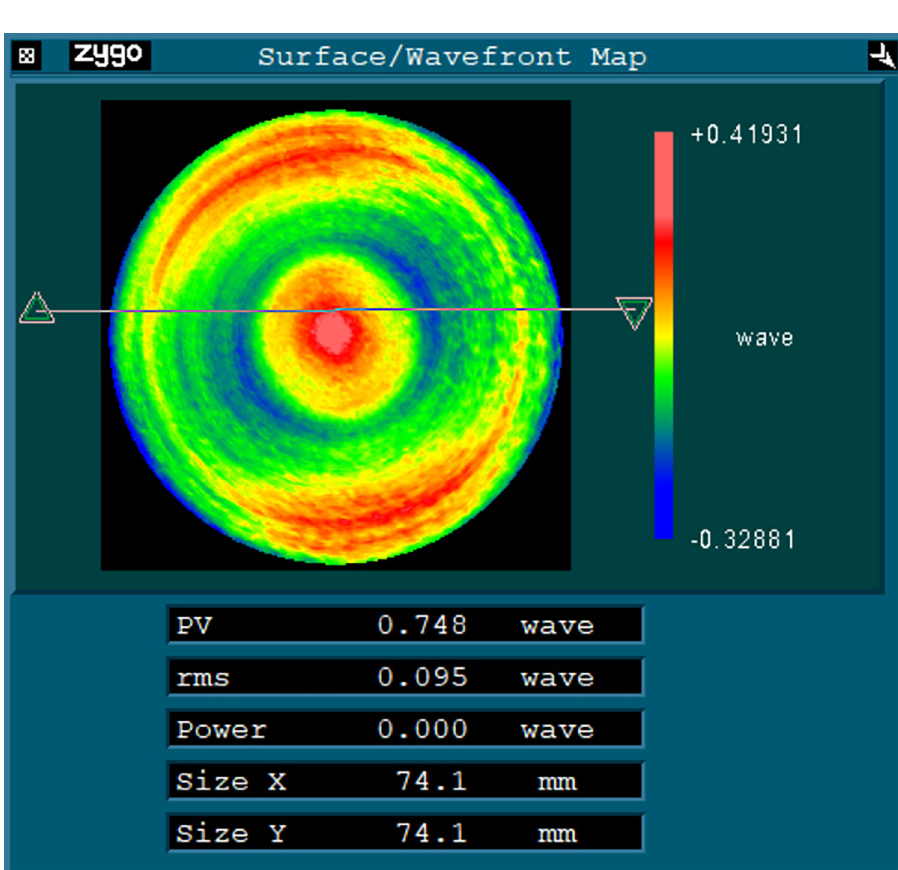
Fig 11. The surface error.